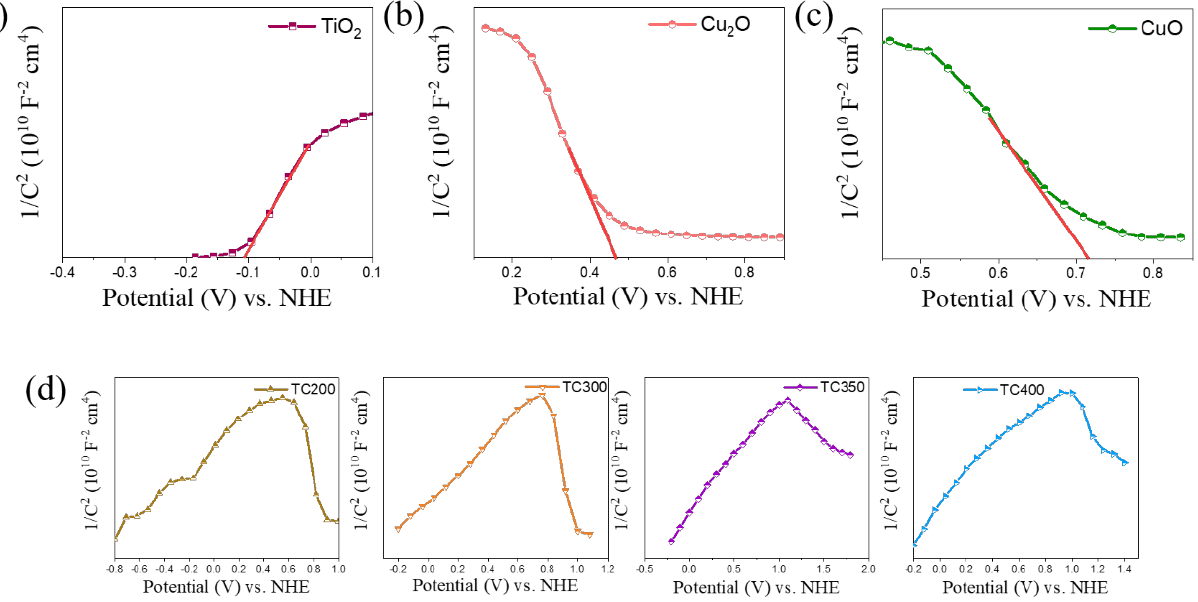
Figure 10. Mott–Schottky plots for various samples: ( a ) TiO 2 , ( b ) Cu 2 O, and ( c ) CuO. ( d ) A series of M − S plots for various composite nanorods.